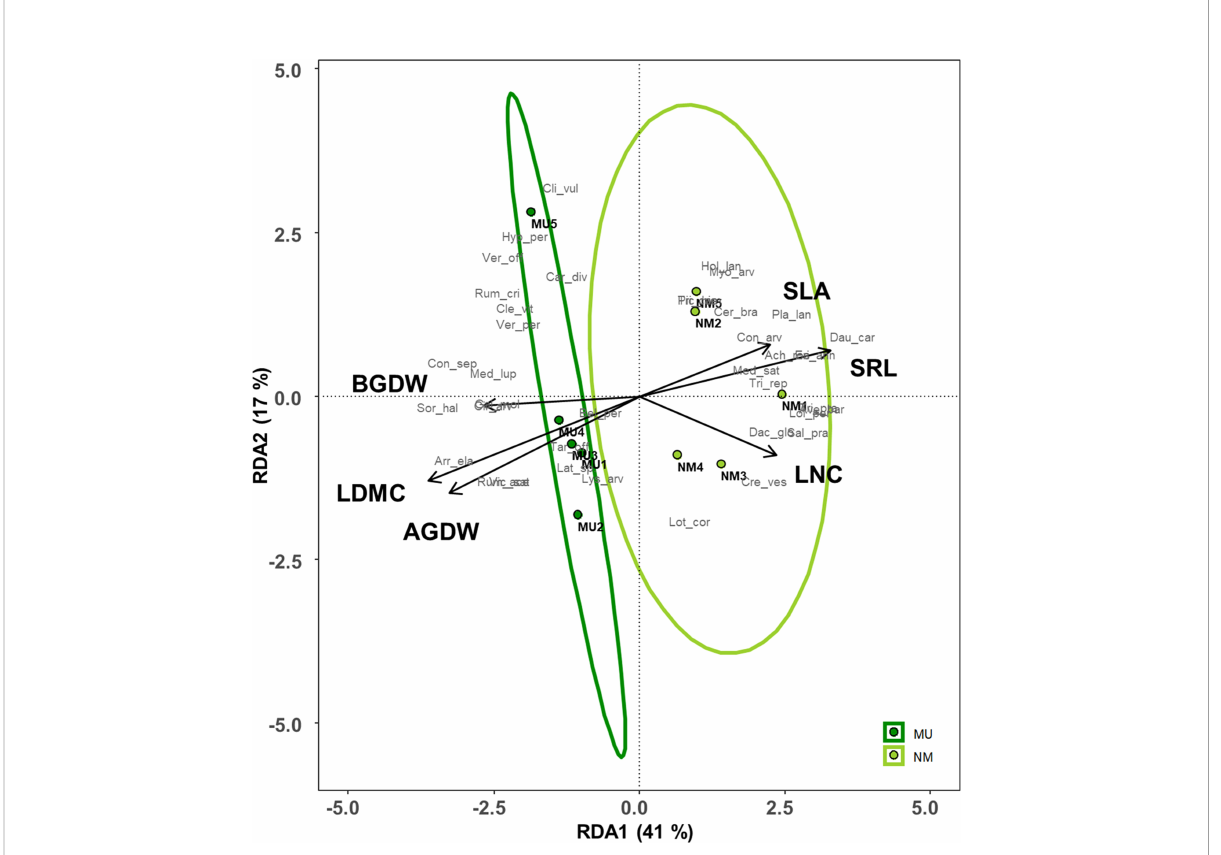
FIGURE 7 Redundancy analysis (RDA) ordination of the plant community composition comparing control (NM; no mulching) and mulching-treated (MU) areas in relation to the community-level plant functional traits that were signi fi cantly affected by the mulching treatment (see Figures 3). The circles represent the 95% con fi dence interval. Legend: AGDW and BGDW, above- and below- ground dry weight, LDMC, community weighted mean (CWM) of leaf dry matter content, LNC, CWM of leaf nitrogen content, SLA, CWM of speci fi c leaf area, SRL, speci fi c root length. Supporting data are reported in Supplementary Table